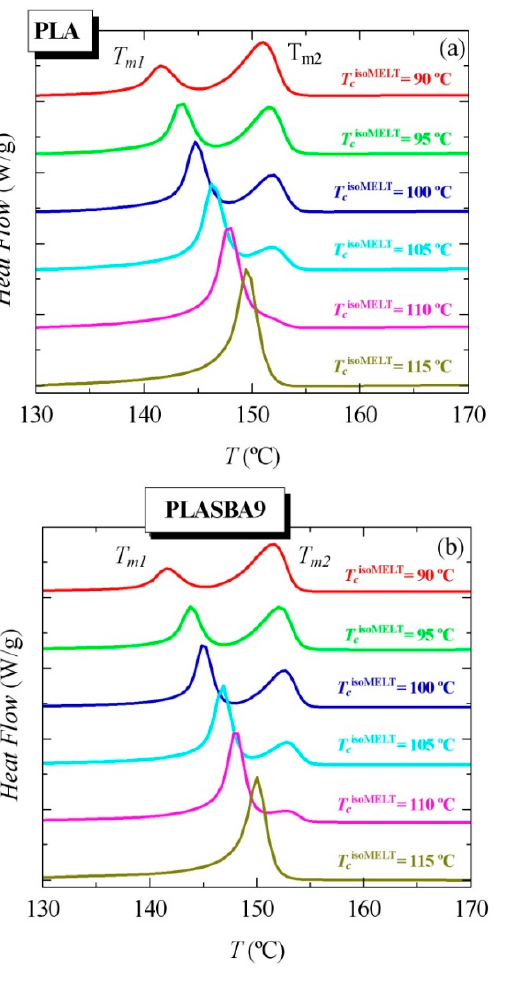
Figure 7. Effect of isothermal crystallization temperature from the melt, T c isothermMELT , on the melting behavior for ( a ) neat PLA and ( b ) its composite PLA-SBA9. ( c ) Relationship of melting temperatures with T c isothermMELT .